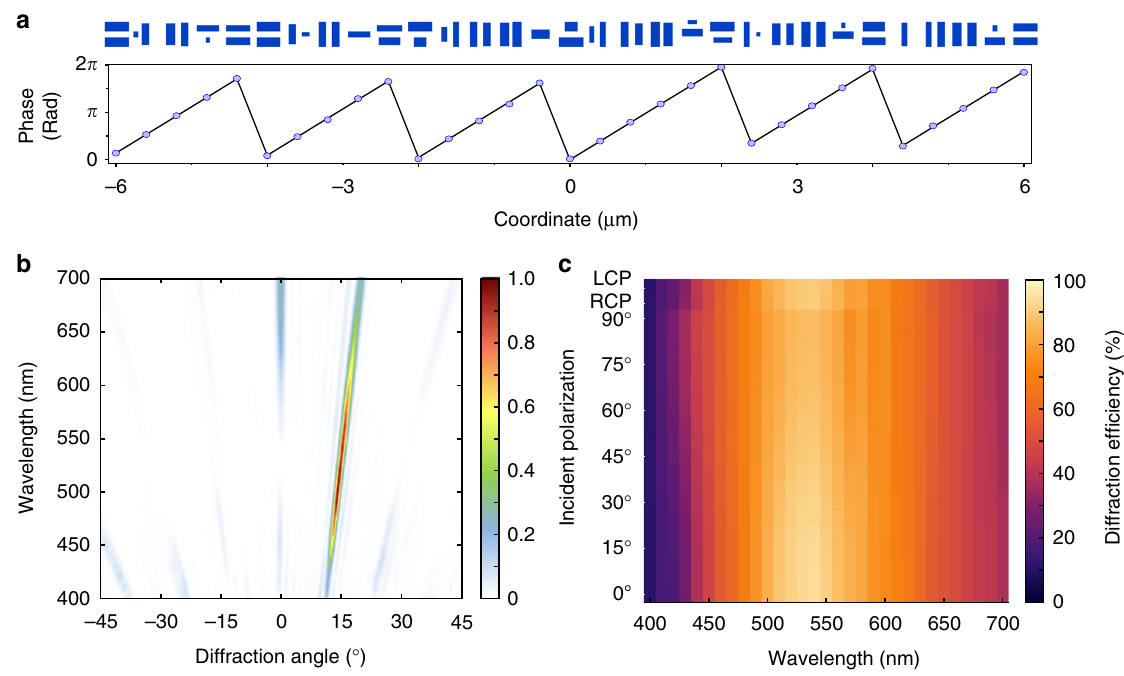
Fig. 4 Simulated results for a polarization-insensitive phase-gradient metasurface. a Layout of the designed metasurface. The metasurface consists of mutually parallel and perpendicular nano fi ns with the geometries and orientations chosen to de fl ect a normal incident beam to an angle of 15 degrees at the design wavelength of 530 nm. The bottom panel shows the target and realized phases in a black line and blue circles, respectively. b Normalized far- fi eld power under x -polarized incidence as a function of incident wavelength and diffraction angles. c Diffraction ef fi ciency (colors) for the metasurface across the visible spectrum under linear and circular polarizations. The polarization angles are labelled on the y -axis, while the last two rows showing the cases for right- and left-handed polarizations. For all wavelengths, the ef fi ciency is maintained at a relatively constant value, which is indicative of